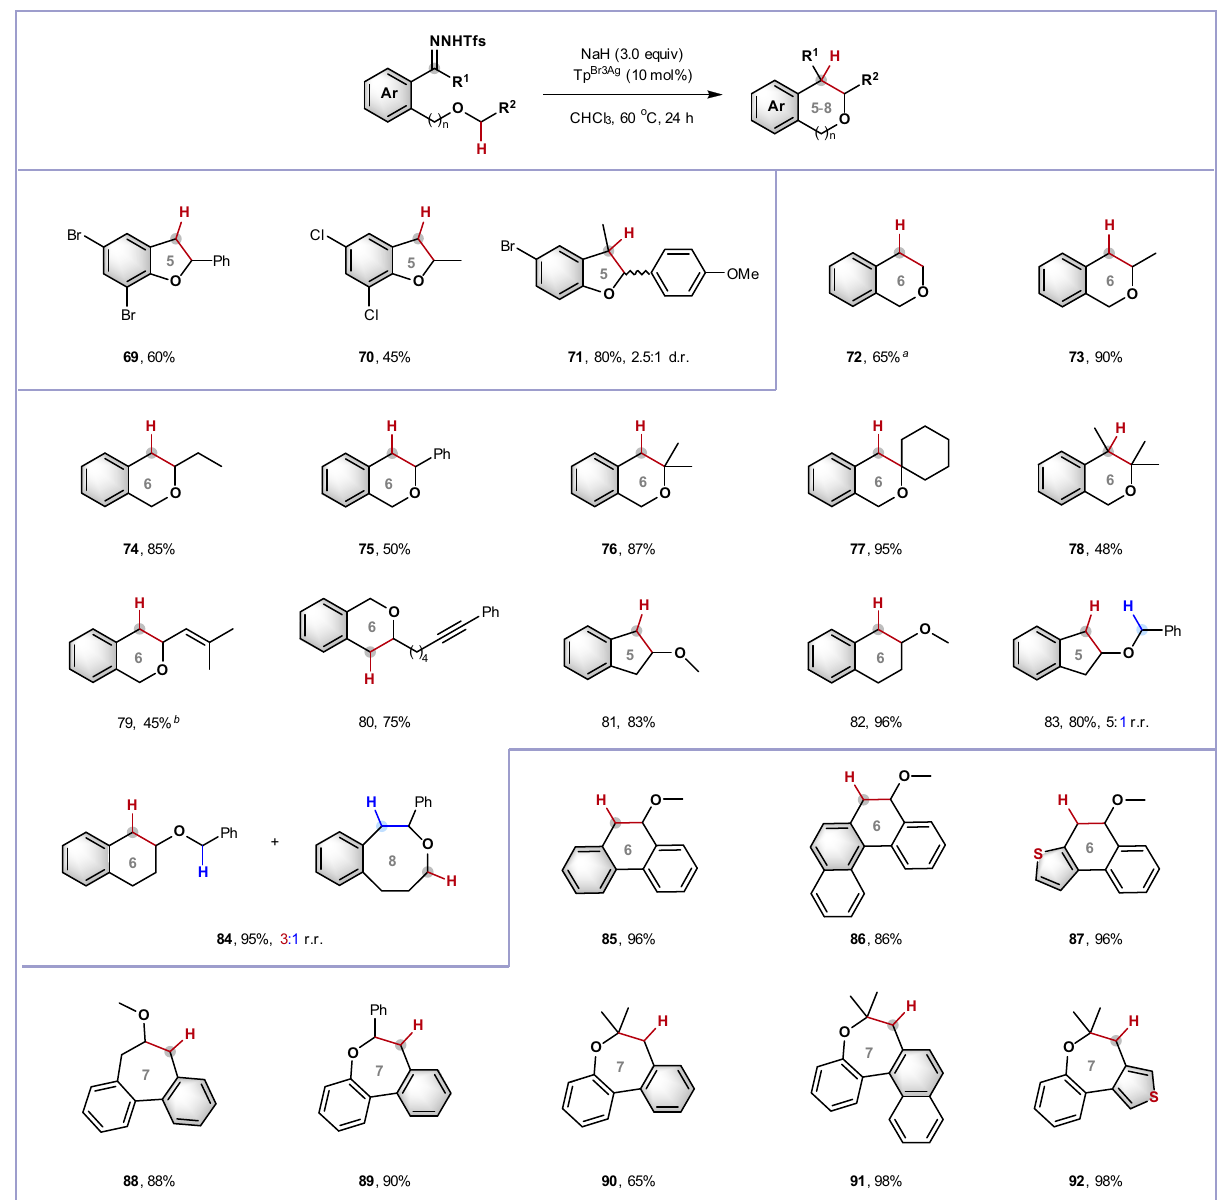
Fig. 5 Silver-catalyzed intramolecular carbene insertion into C(sp 3 ) – H bonds adjacent to ether oxygen. Standard conditions: N -Triftosylhydrazone (0.3 mmol), NaH (0.9 mmol), Tp Br3 Ag (10 mol%), and CHCl 3 (5.0 mL), under argon atmosphere at 60 °C for 24 h, isolated yield. a CHCl 3 (10.0 mL) was used. r.r., regioisomeric ratio; d.r., diastereomeric